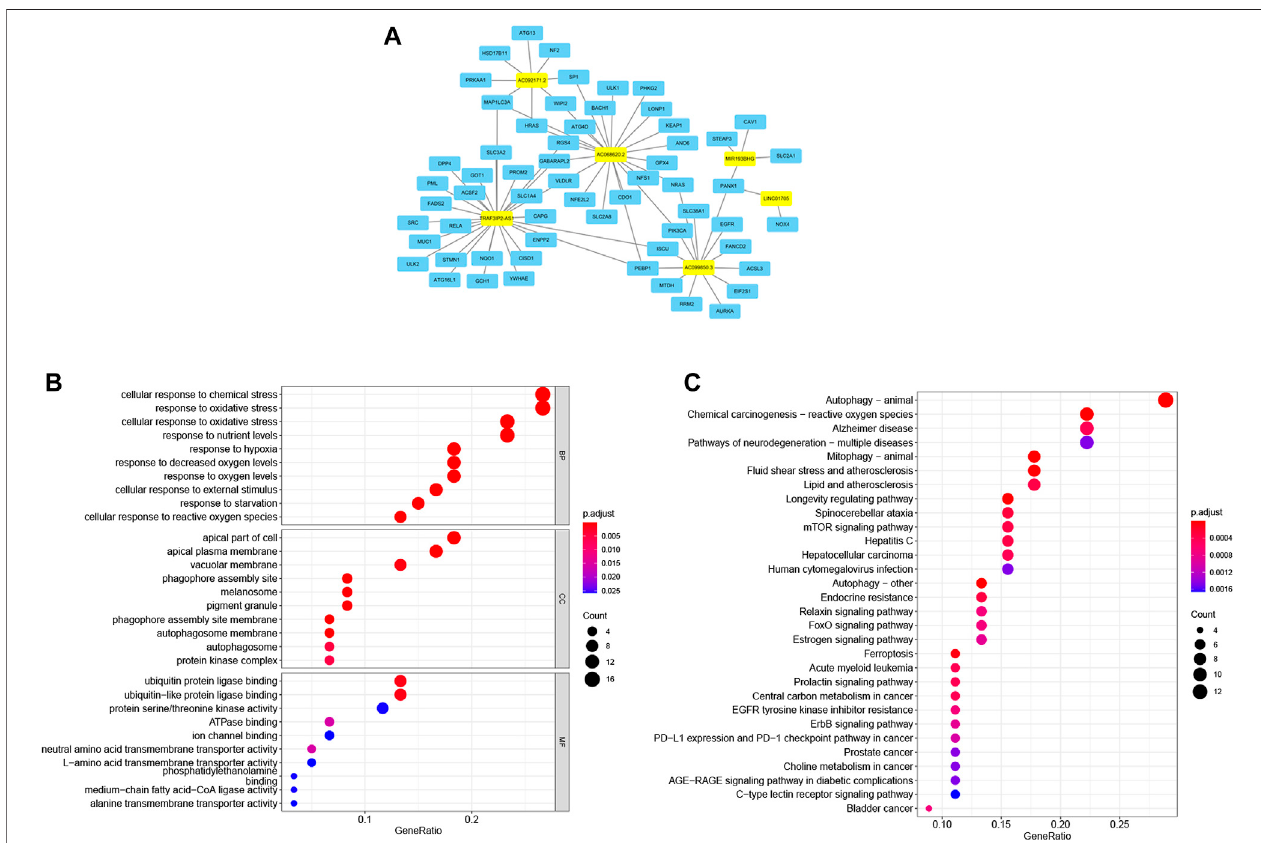
FIGURE 8 | Ferroptosis-related lncRNA-mRNA co-expression network and functional enrichment. (A) LncRNA-mRNA network showing 76 lncRNA-mRNA co- expression pairs formed between six FRLs and 61 mRNAs. The yellow rectangles denote FRLs, and the blue rectangles denote mRNAs. (B) GO analysis showing enriched biological function of these mRNAs co-expressed with six FRLs. (C) KEGG pathway analysis showing enriched signaling